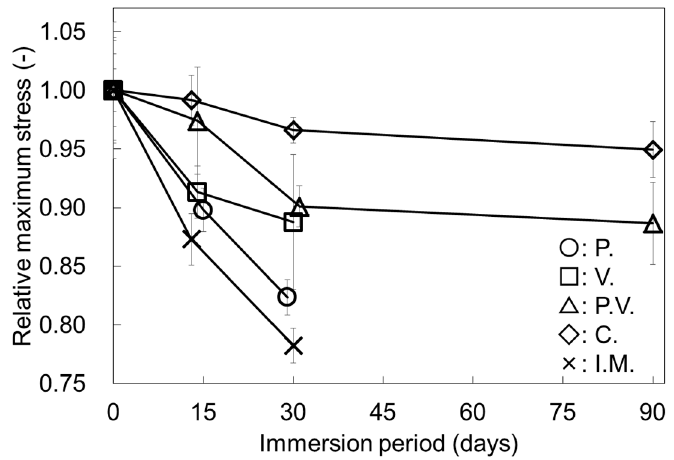
Figure 8. Comparison of the maximum stress changes of the five test piece types. The maximum stress was divided by the average value of non-immersed test pieces (0 day). Average ± S.D., n = 5. The points were staggered to prevent overlap. The tensile test could not be performed on the test pieces fabricated by scan patterns P., V., and I.M., after 90 days of immersion.